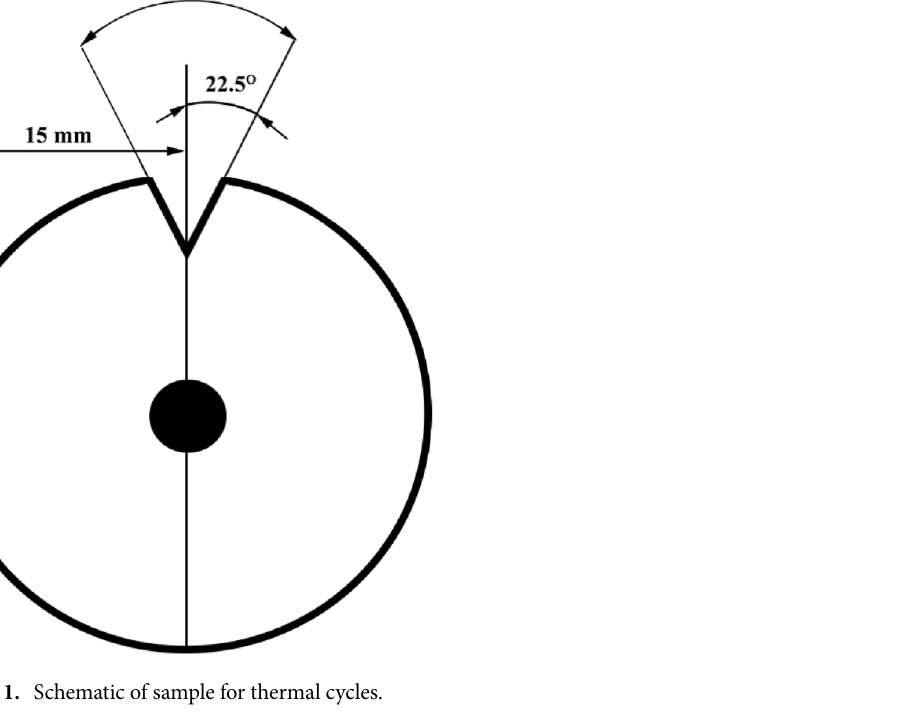
Figure 1. Schematic of sample for thermal